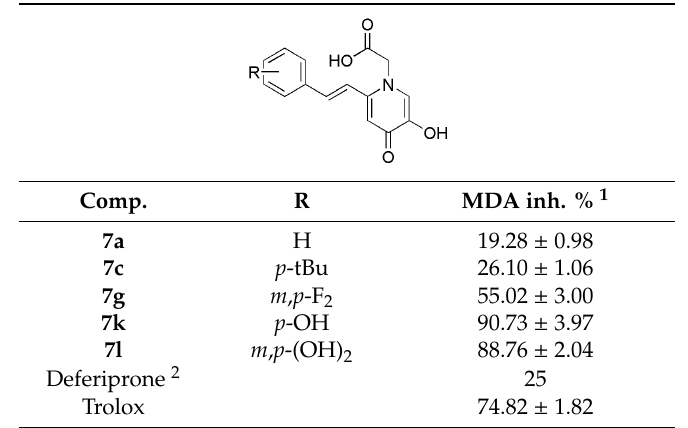
Table 3. Inhibition data of lipid peroxidation for 5-hydroxy-4-oxo-2-styryl-4H-pyridinone derivatives.